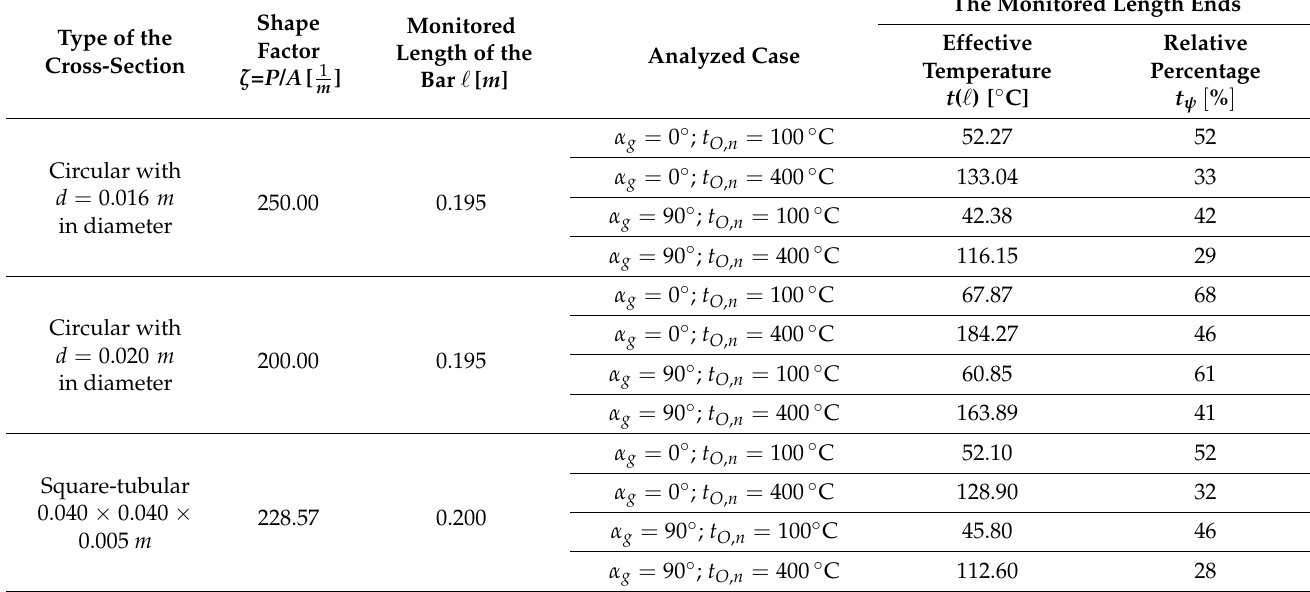
Figure 14. The comparative, relative t ψ [ % ] thermal distribution laws for α g = 90 ◦ and t O , n = 400 ◦ C. Table 2. The monitored ends of the bars.